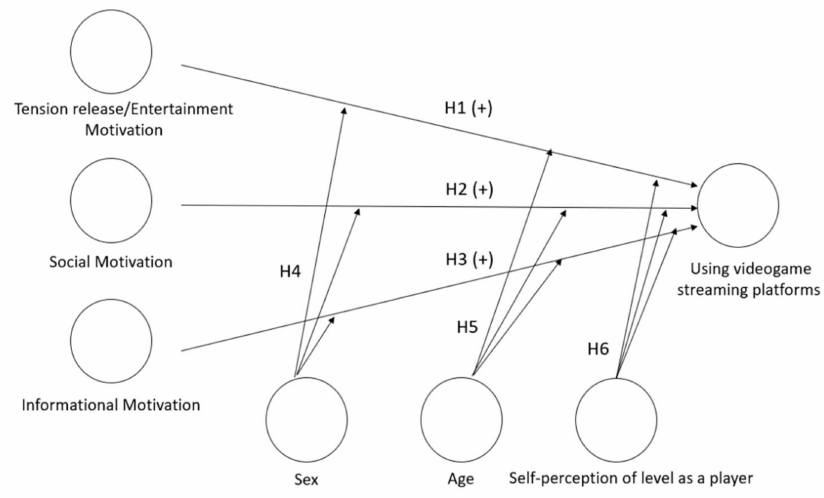
Figure 1. Research